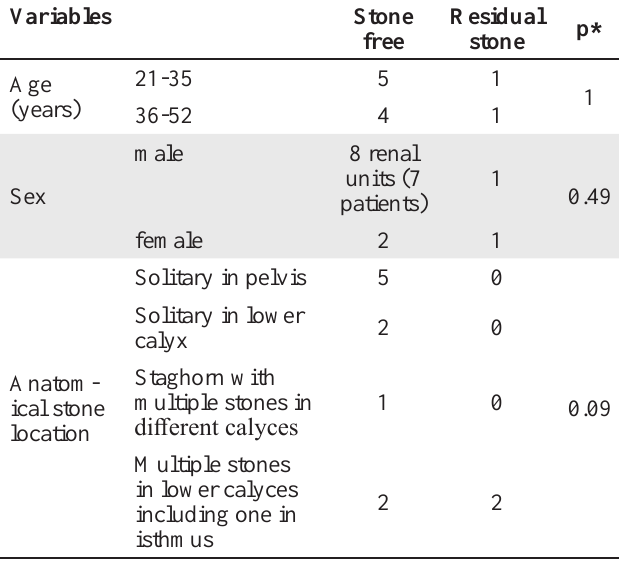
Table 2. Comparisions of variables of patients with horseshoe kidneys undergoing PCNL Variables Stone